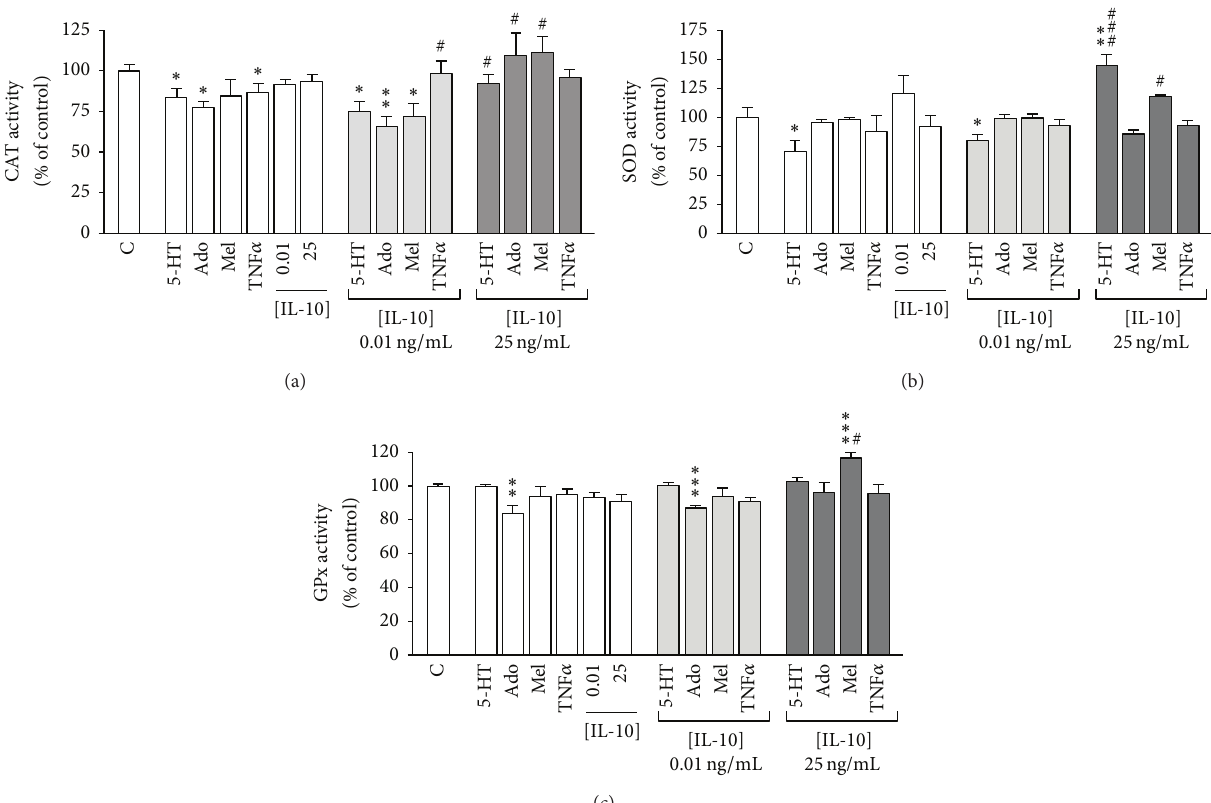
Figure 2: Effect of 5-HT, adenosine, melatonin, TNF 𝛼 , and/or IL-10 on CAT (a), SOD (b), and GPx (c) activity. Caco-2 cells were treated throughout the course of one day with 5-HT 100 𝜇 M, adenosine (Ado) 100 𝜇 M, melatonin (Mel) 5mM, TNF 𝛼 5ng/mL, or IL-10 at two concentrations, 0.01 or 25 ng/mL. Results were expressed as percentages of the enzyme activity of control cells (100%) and were indicated as the mean ± SE of five independent experiments. ∗ 𝑃 < 0.05 , ∗∗ 𝑃 < 0.01 , and ∗∗∗ 𝑃 < 0.001 , compared with control (C); # 𝑃 < 0.05 , and ### 𝑃 < 0.001 compared with the corresponding condition of treatment without